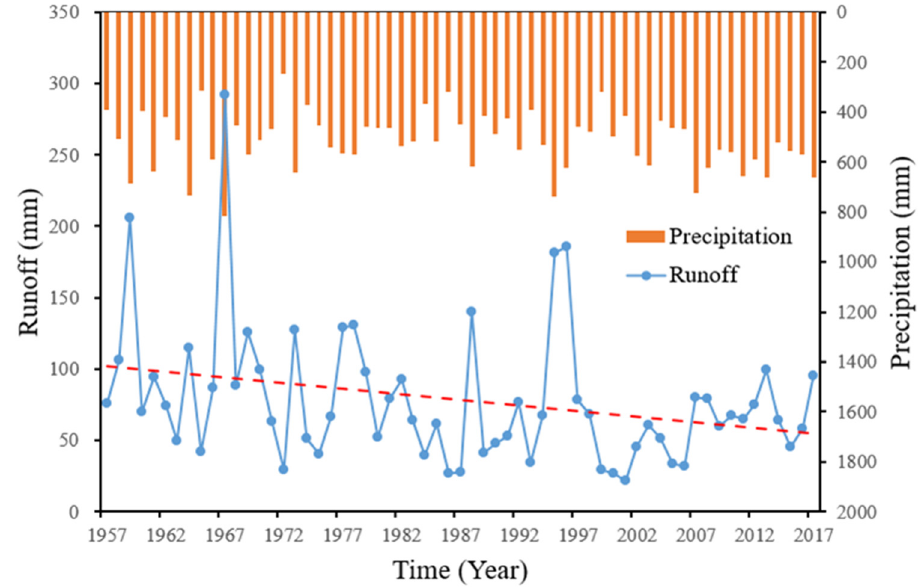
Figure 6. The double mass curve of cumulative annual runoff plotted against cumulative annual precipitation and their linear regressions during the different periods of 1952–2017.